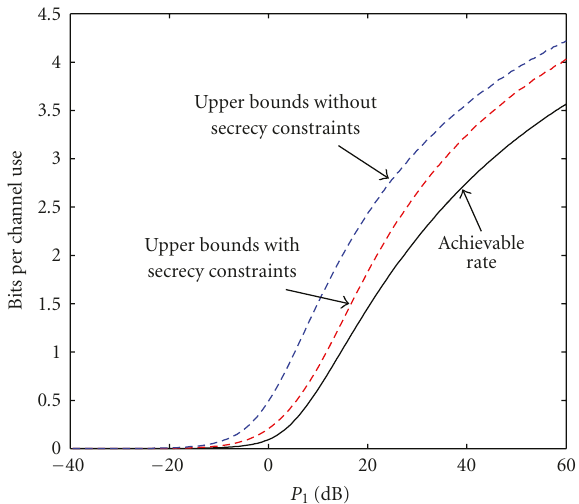
Figure 10: Secrecy Rate, P r = 40dB, P 2 = 0 . 25 P 1 , optimized over α.